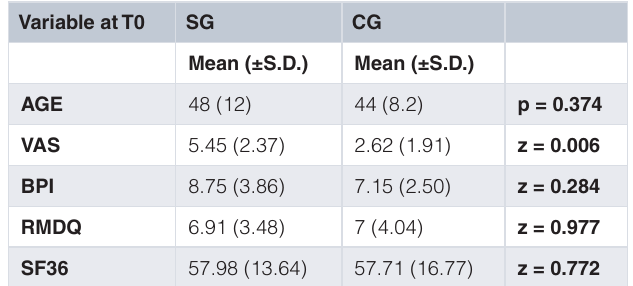
Table 1. Baseline values for measured outcomes. S.D. = standard